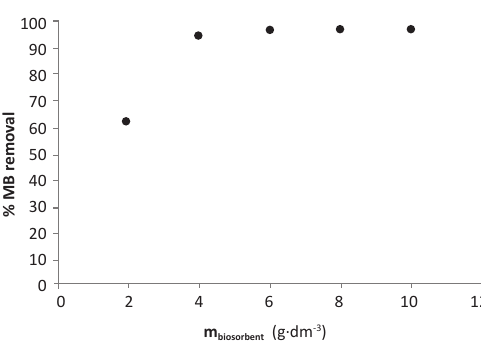
figURe 4. The effect of biosorbent concentration on the adsorption of MB onto poplar sawdust (γ t=120 min, T=298.15 K, pH=7, 150 rpm).